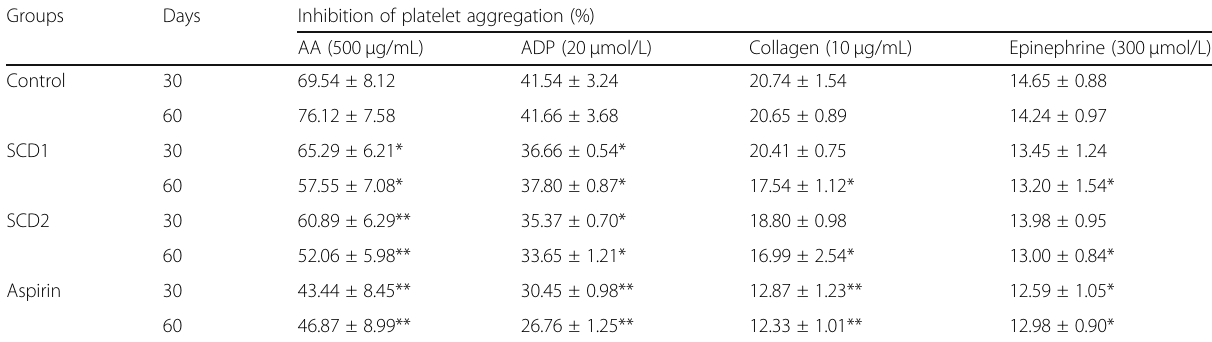
Table 3 In vivo comparison of S. cumini leaves extract, aspirin and control on inhibition of platelet aggregation in rabbits. Agg RAM aggregometer was used to perform this test. Blood was taken in the ratio of 9:1 v/v in trisodium citrate (3.8%)